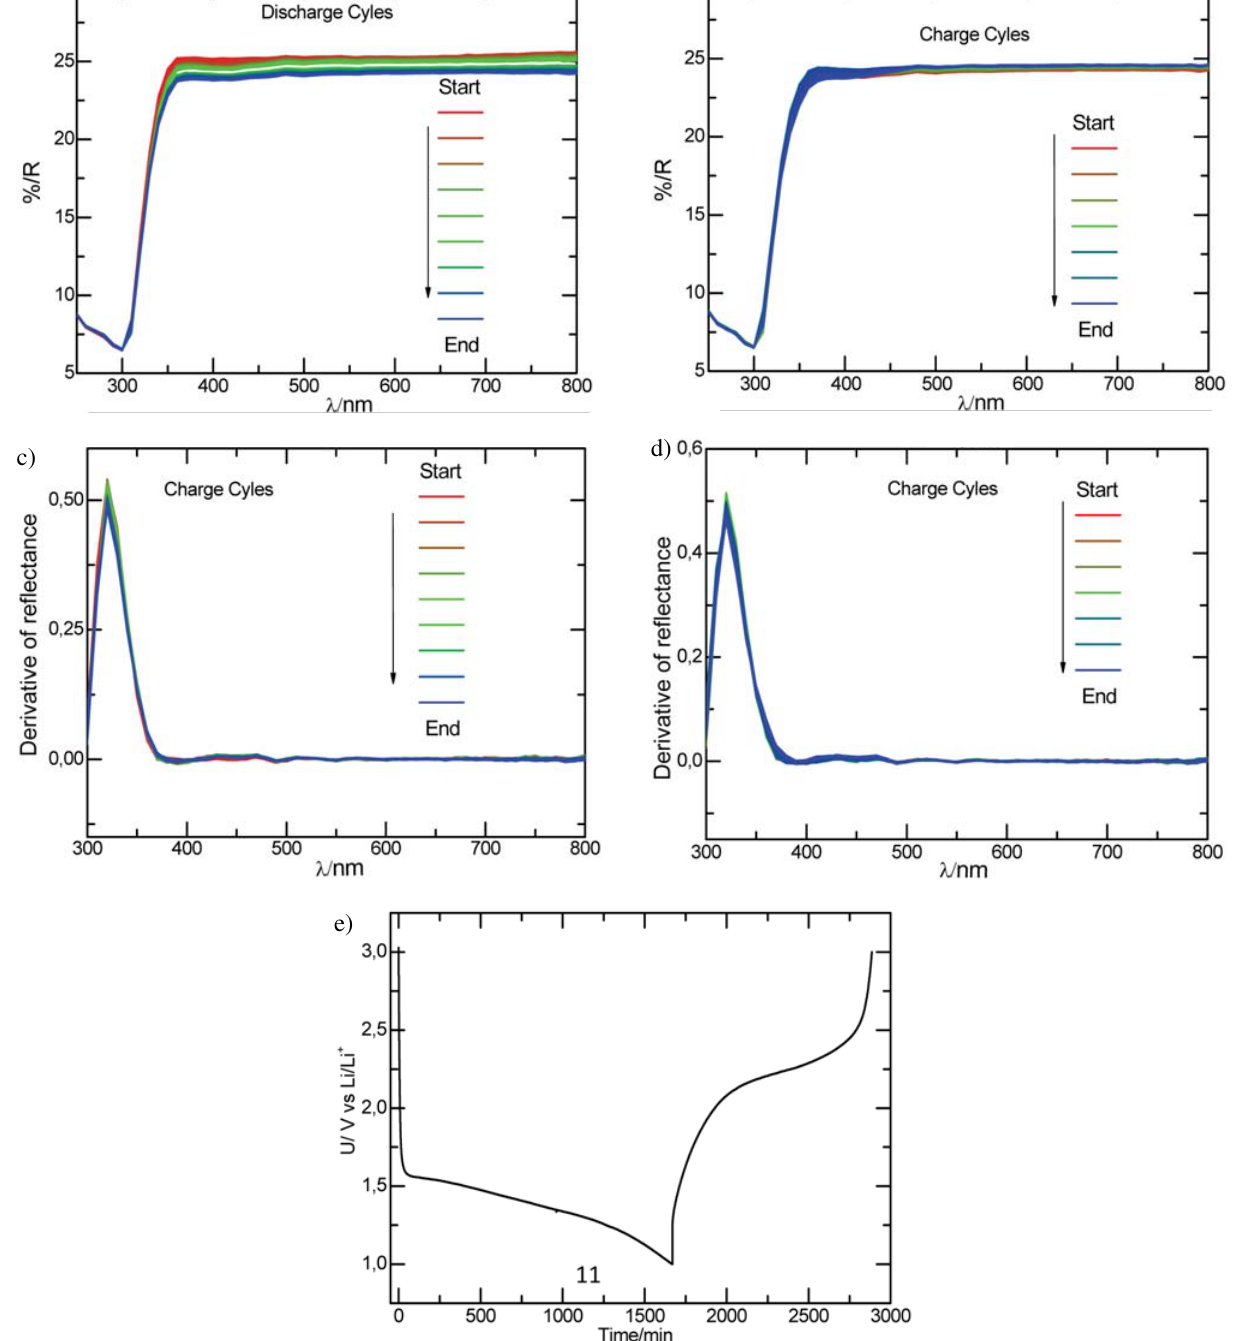
Figure 5. a, b) Obtained UV-Vis spectra from discharge and charge cycle of PAN/S composite. c, d) The first derivative of the obtained spectra during discharge and charge cycle showing shifts in the wavelength. e) The electrochemical curve of in-situ UV-VIS measurement of PAN/S